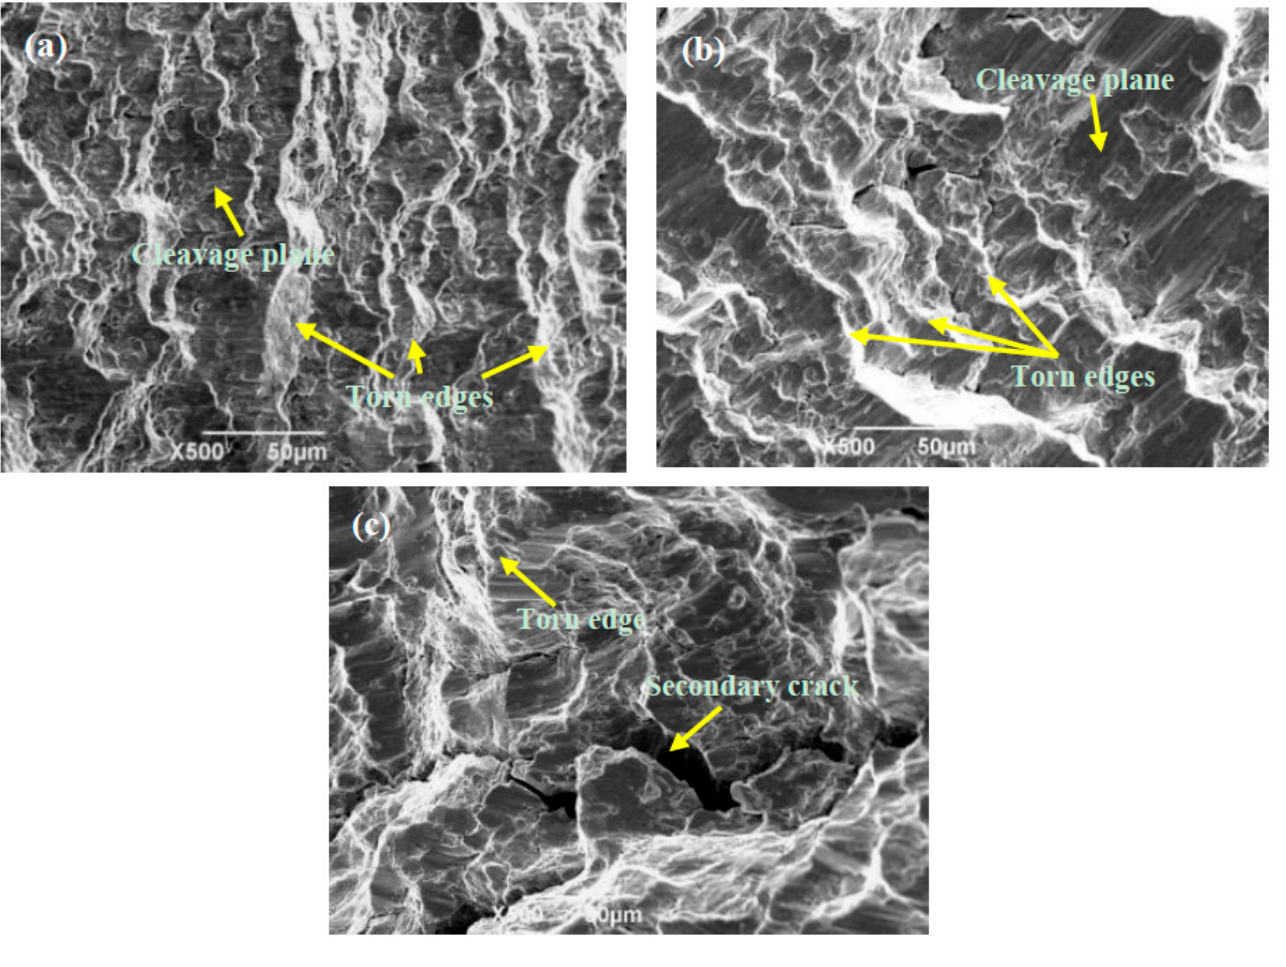
S = 458.6 MPa, ( b ) S = 509.6 MPa, ( c ) eq eq